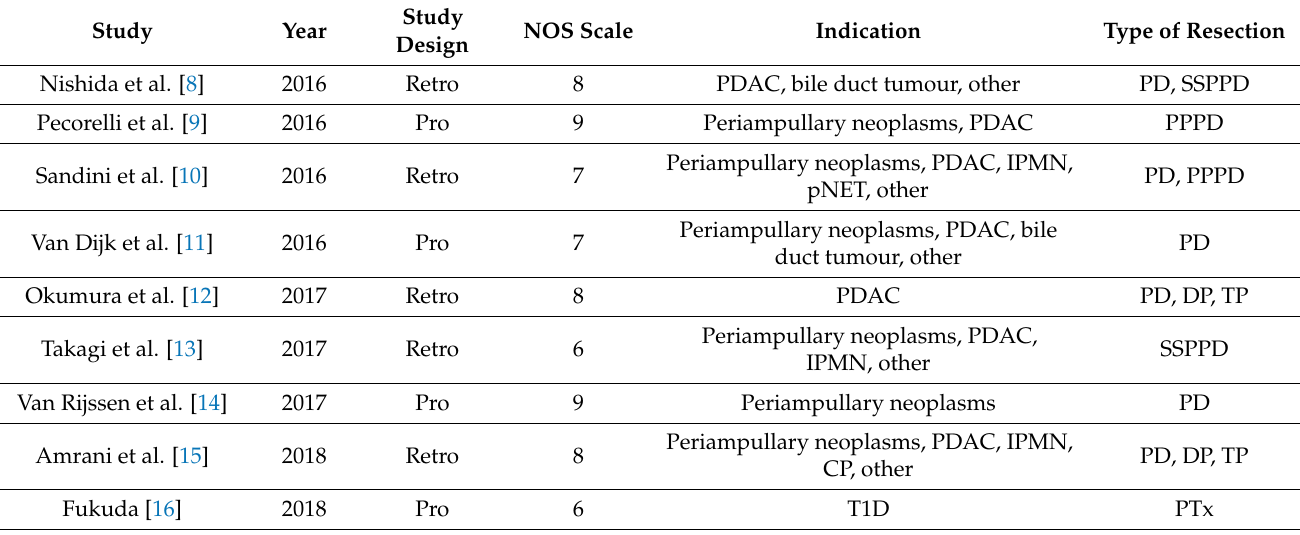
Table 1. Study characteristics, indications, and types of